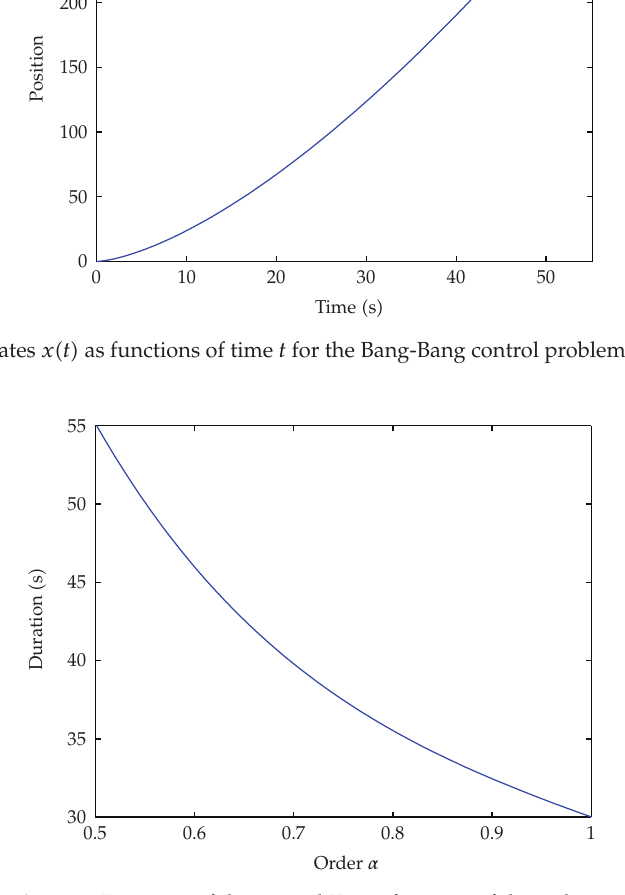
Figure 7: Duration of the control T as a function of the order α